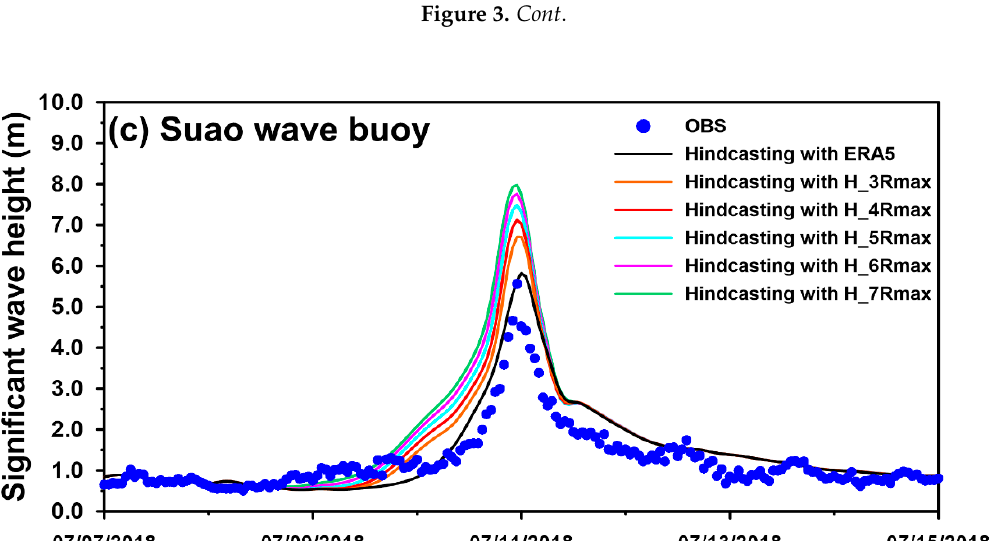
J. Mar. Sci. Eng. 2021 , 9 , x FOR PEER REVIEW